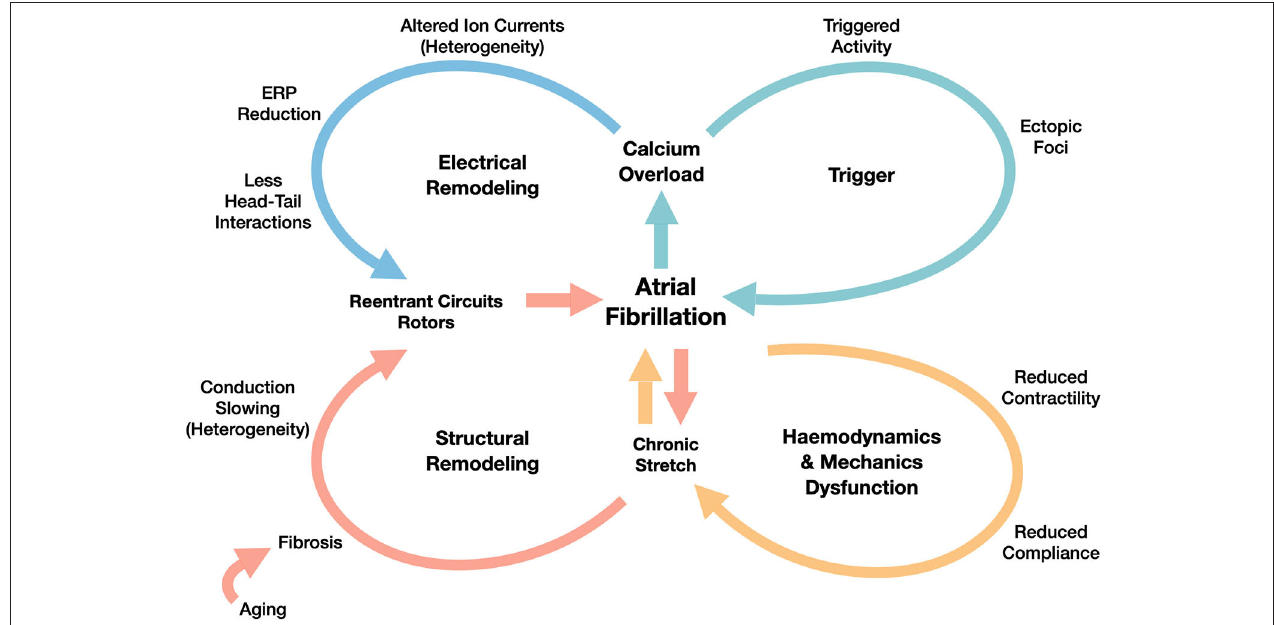
FIGURE 1 | Overview of AF mechanisms generated by the interplay between functional (electrical remodeling and triggering) and structural factors (structural remodeling generated by the hemodynamics and mechanics dysfunction). We refer to Schotten et al. (2011) for the details of those mechanisms.